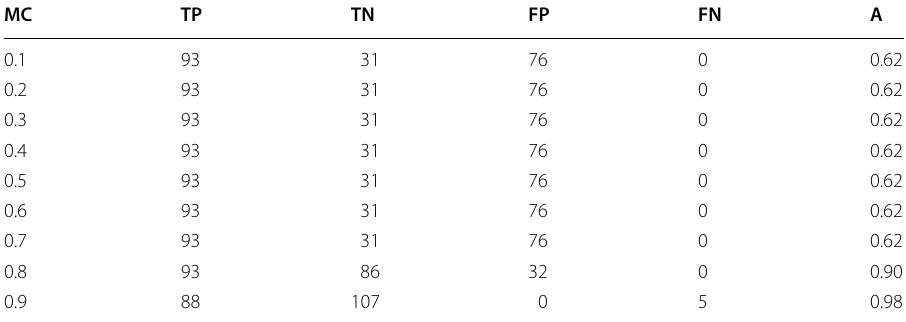
where MC minimum confidence , TP true positive, TN true negative, FP false positive, FN false negative, A